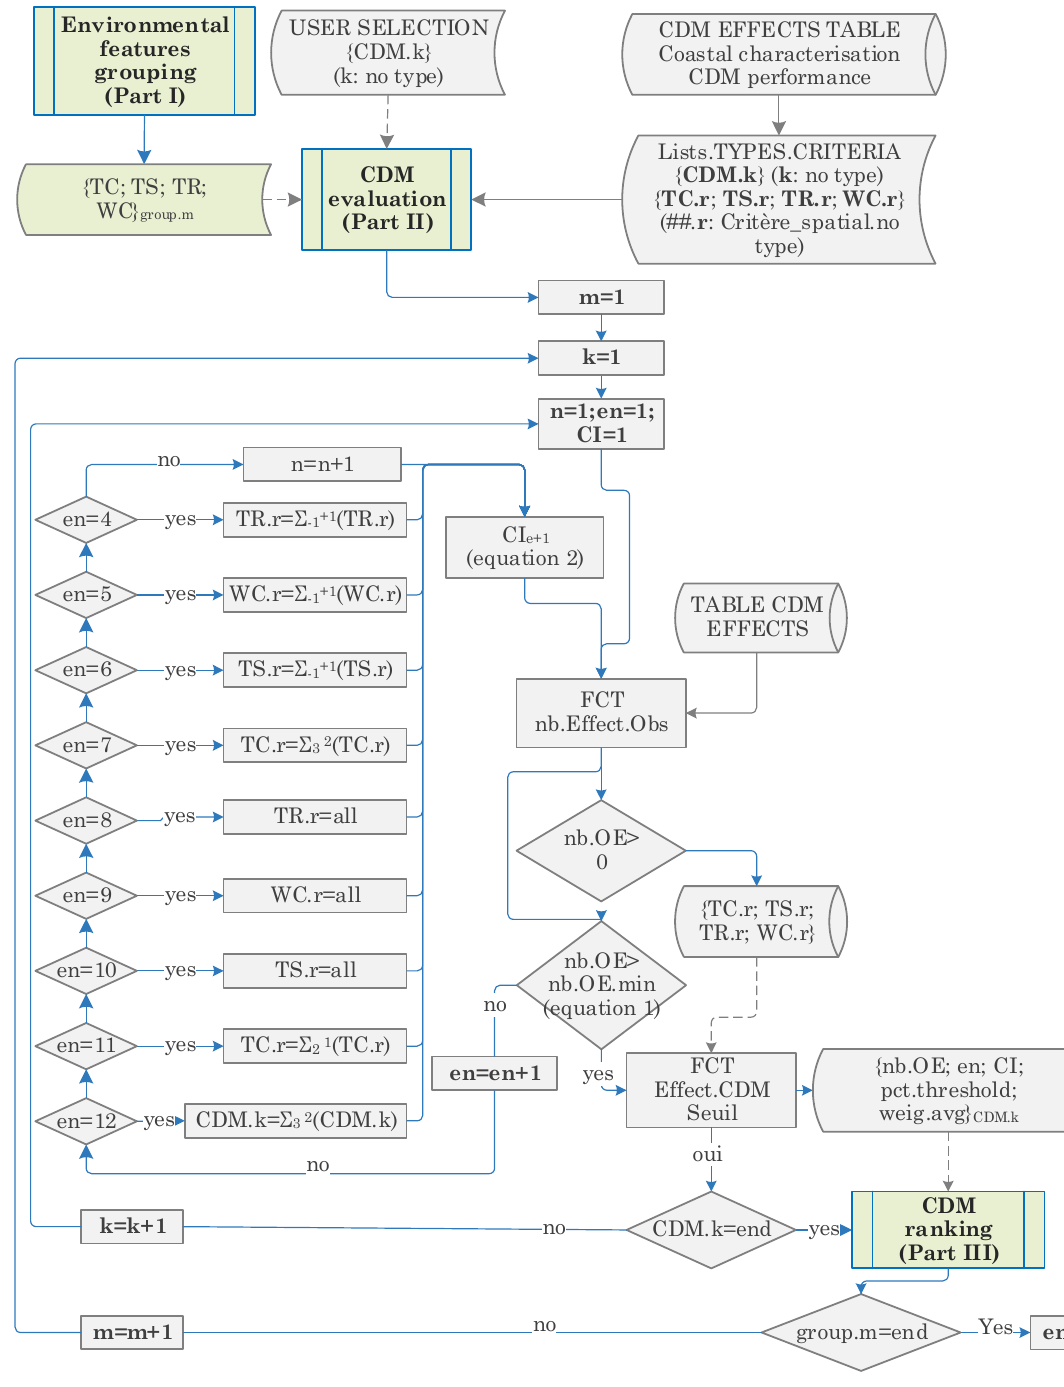
Figure 4. Graphic illustration of CDMIA procedure for CDM evaluation.